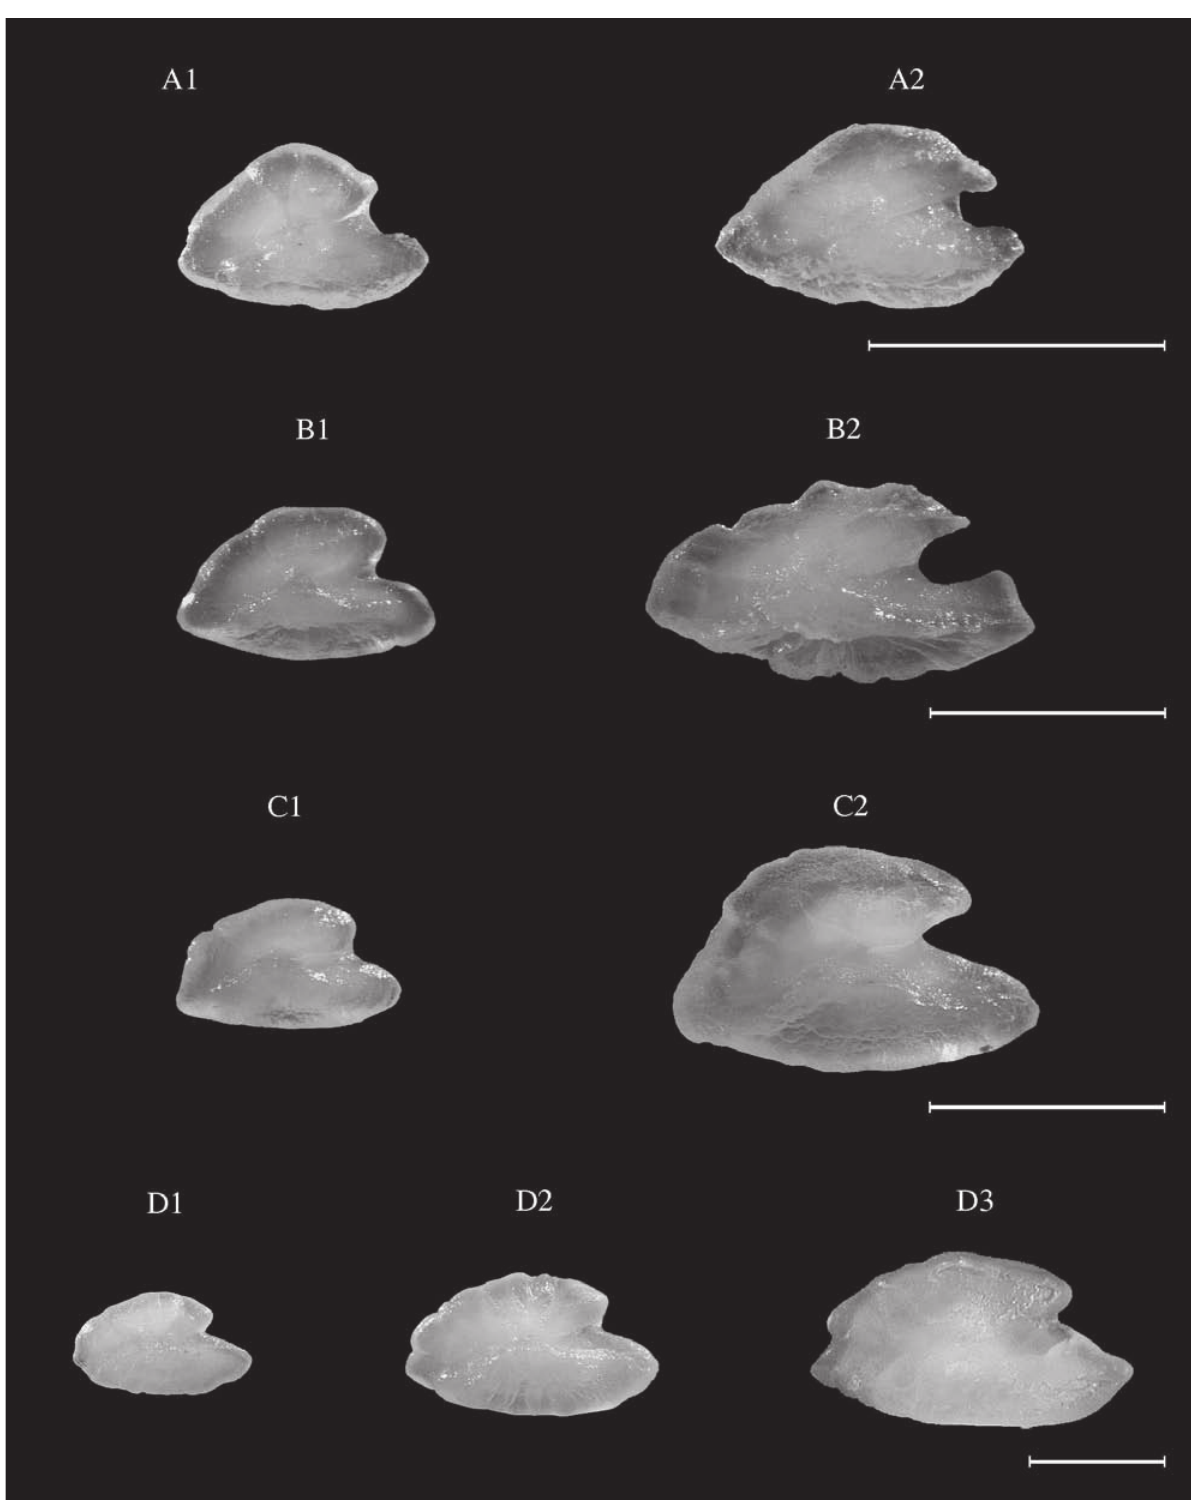
Fig. 76. – Coryphoblennius galerita (NEA) . TL: A1, 4.2 cm; A2, 6.2 cm. Lipophrys pholis (NEA) . TL: B1, 5.2 cm; B2, 9.7 cm. Lipophrys trigloides (NEA) . TL: C1, 5.0 cm; C2, 9.2 cm. Parablennius gattorugine. TL: D1, 5.0 cm (NEA); D2, 9.2 cm (NEA); D3, 11.5 cm (WM). Scale bar = 1